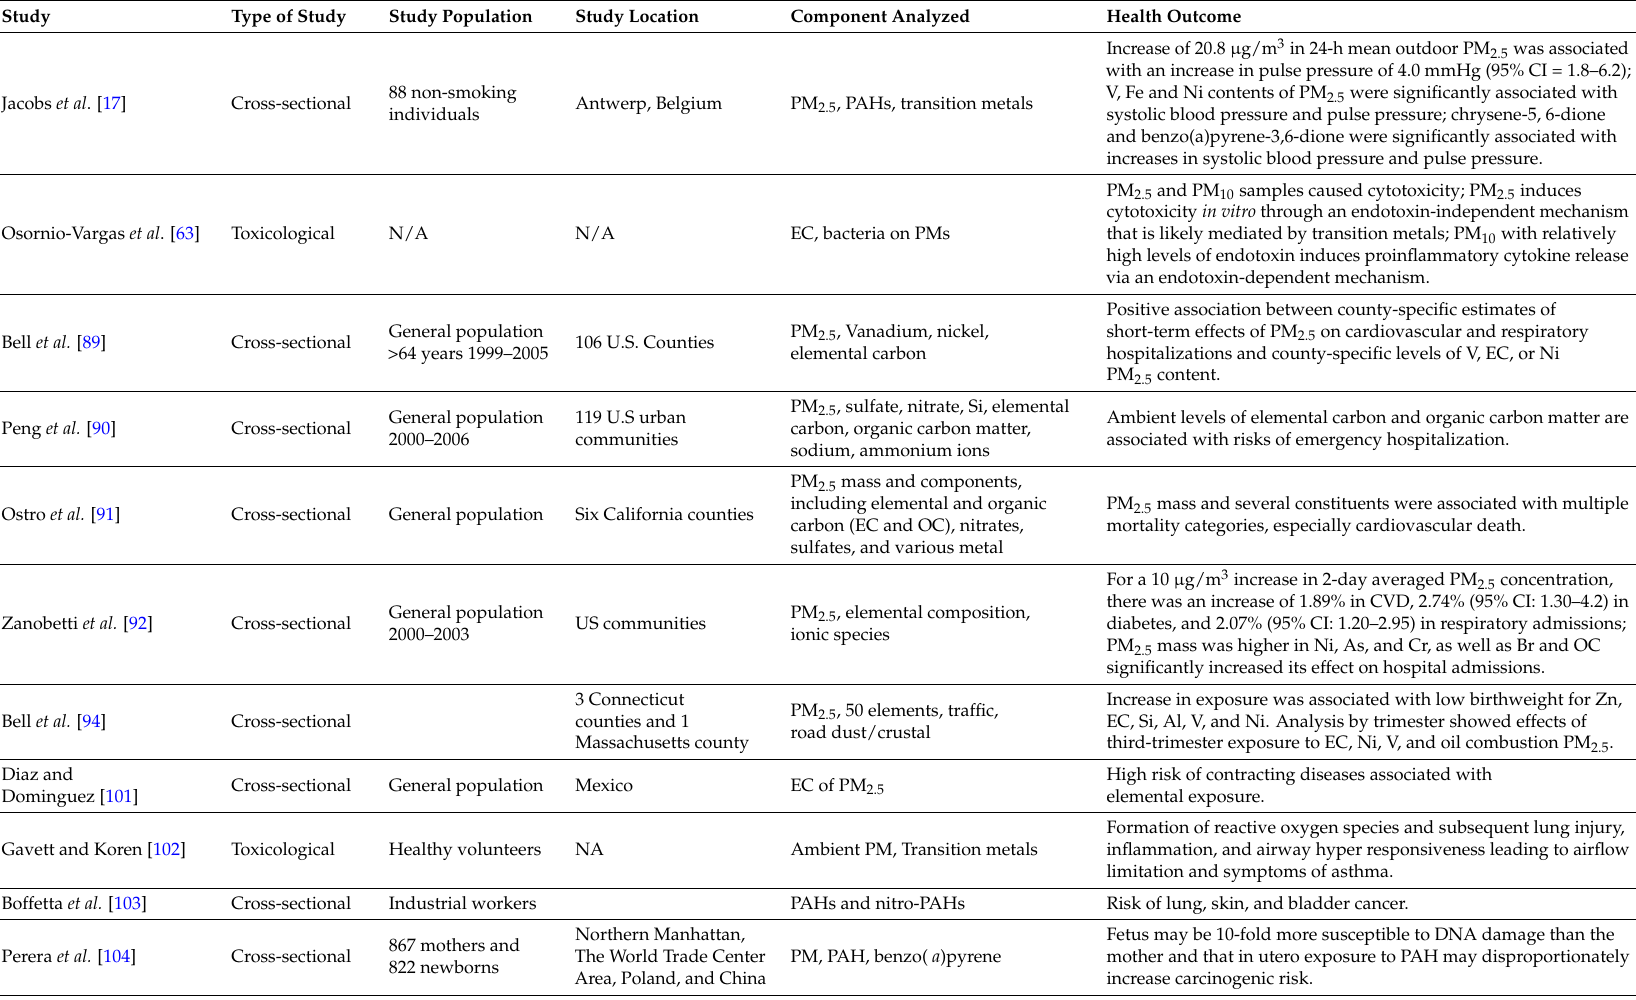
Table 2. Summary of epidemiological and toxicological studies on health effects of exposure to chemical components of